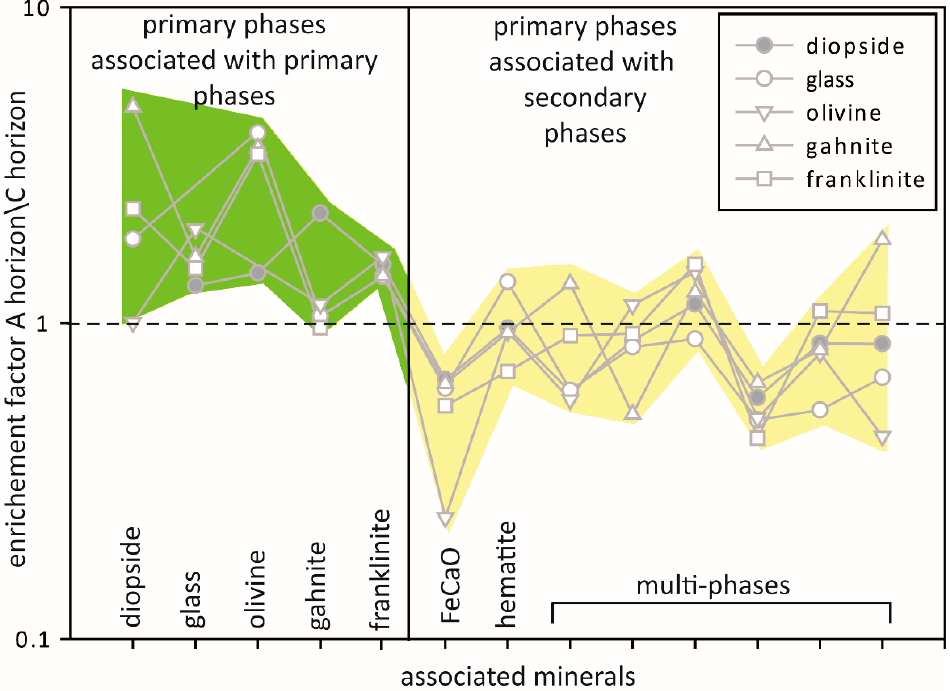
Figure 7. Comparison of minerals associated with major primary phases between horizons A and C. The enrichment factor (EF) shows the predominance of the association in horizon A (values of EF > 1) or in horizon C (values EF < 1). For example, the first column shows values for diopside associated with different primary minerals and EF > 1 are observed for spinels and glass consistent with the predominance of these associations in horizon A. On the other hand, secondary FeCaO phase is predominately associated with primary minerals in horizon C consistent with EF < 1 for all the primary phases.